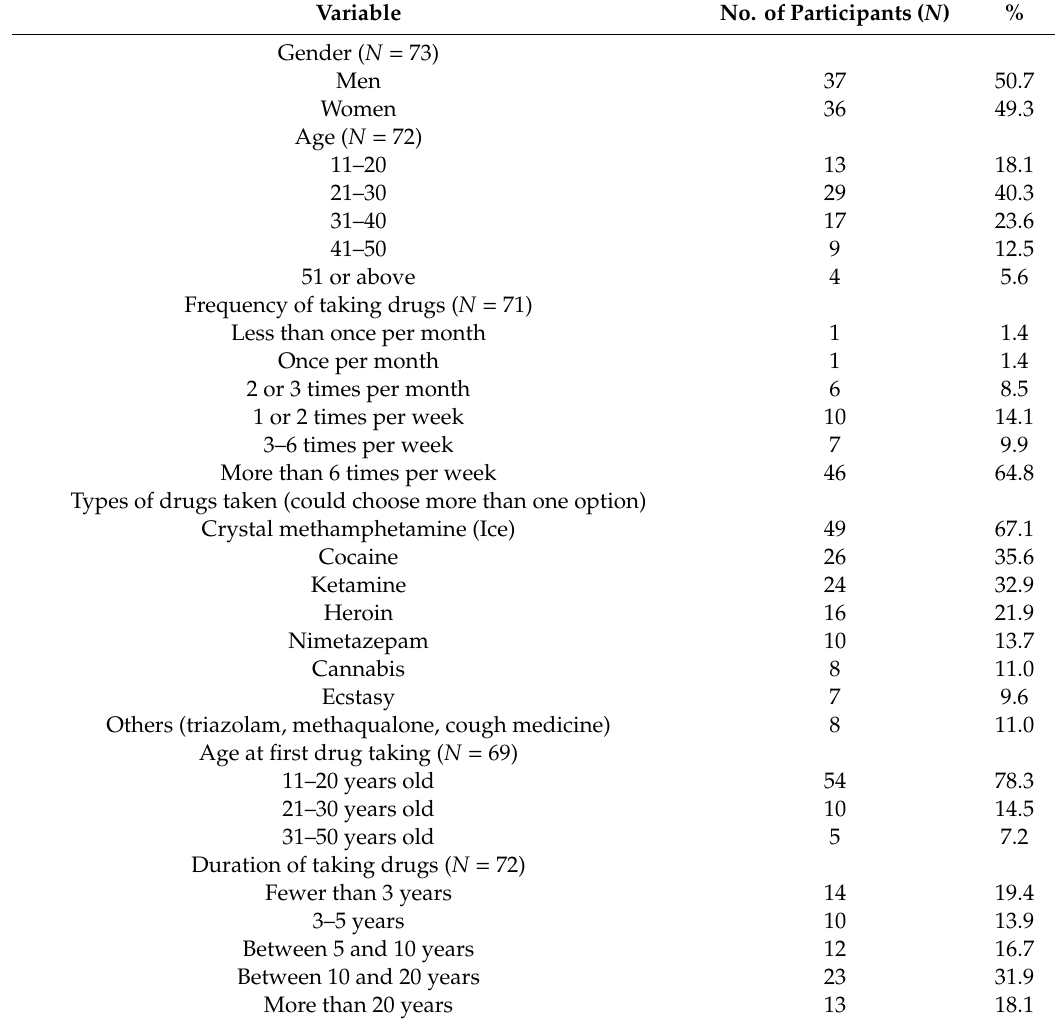
Table 1. Participants’ demographic and drug use data.